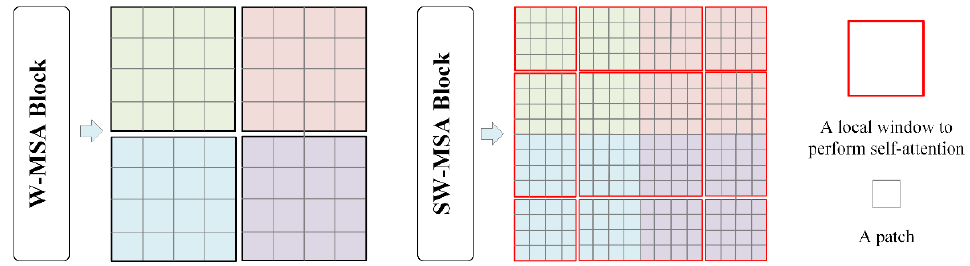
Figure 5. Explanation of the shift window method for calculating self-attention in the Swin Trans- former